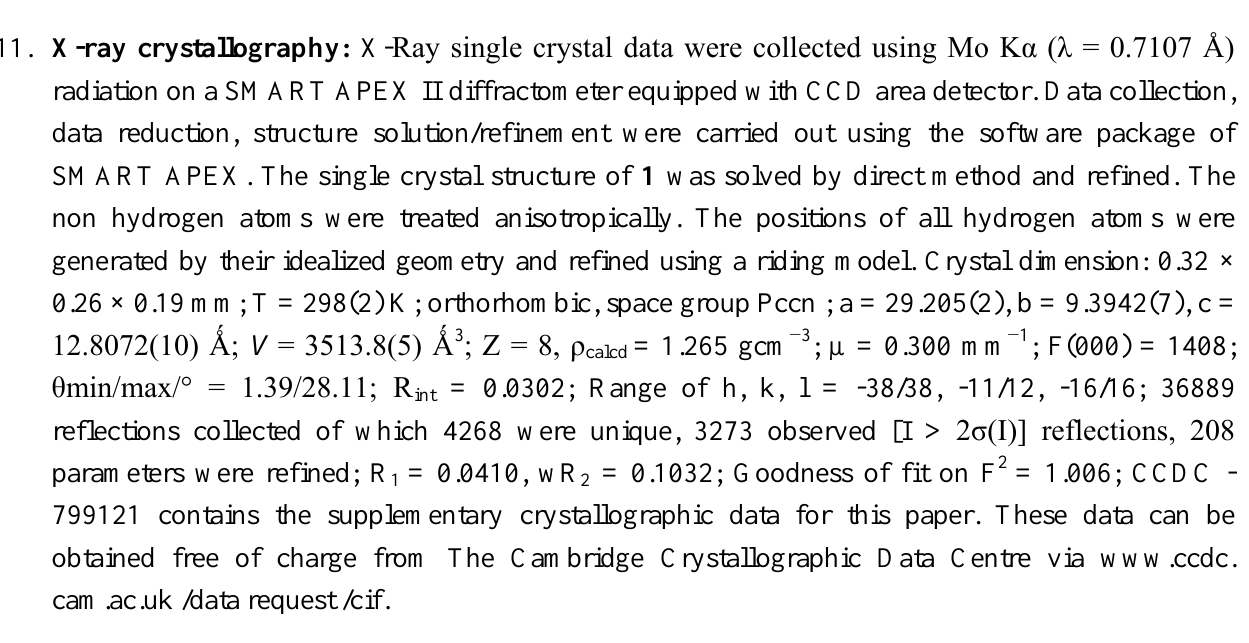
11. X-ray crystallography: X-Ray single crystal data were collected using Mo Kα (λ = 0.7107 Å) radiation on a SMART APEX II diffractometer equipped with CCD area detector. Data